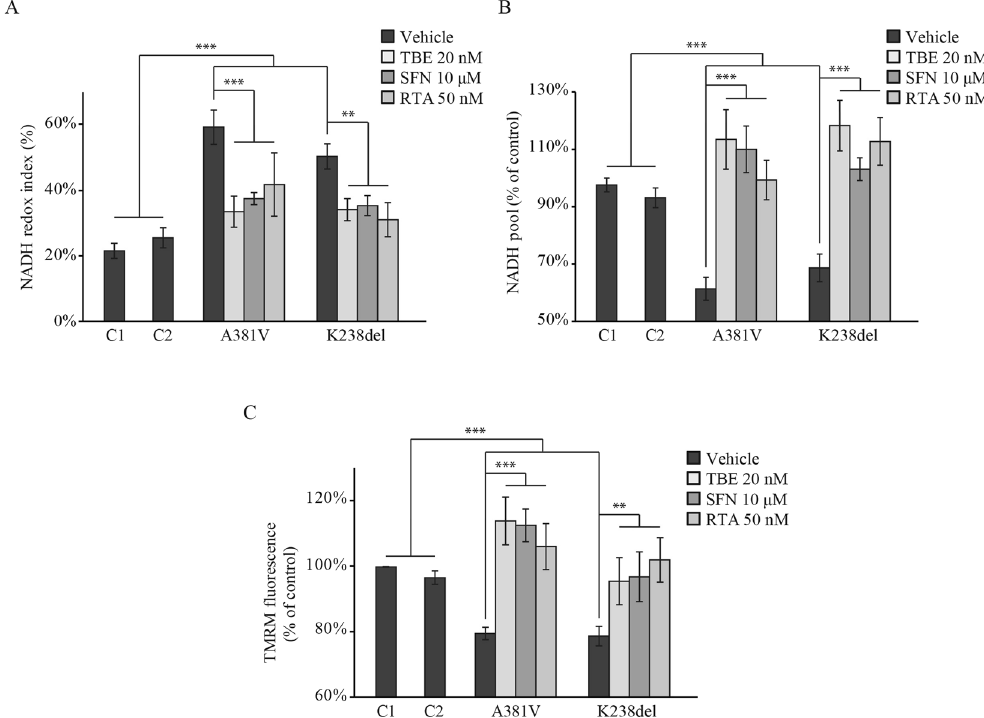
Figure 5. Nrf2 activators restore the p62 deficient phenotype. ( A) NADH redox index was evaluated after incubation with the Nrf2 activators TBE-31(TBE, 20 nM), sulphoraphane (SFN, 10 μ M) and the synthetic triterpenoid RTA-408 (RTA, 50 nM). Cells were plated on 25 mm coverslips in 6 well plates. When they reached 70% confluency, cells were treated 24 hours with TBE, SFN and RTA separately. NADH redox index was calculated as the basal level relative to maximal respiration after FCCP (1 mM) (0%) and inhibited respiration after NaCN (1 mM) (100%) (see Fig. 2B) in fibroblasts from patients carrying the A381V and K238del pathogenic mutations in p62 compared to two control fibroblasts (C1, C2) in presence of the Nrf2 activators. All data represents the mean of at least 3 independent experiments ± SEM. In all cases ** indicates p < 0.01 and *** indicates p < 0.001 compared with the values in control cells. ( B ) NADH pool expressed as absolute values between maximal and minimal respiration (see Fig. 2B) in control and patient fibroblasts in presence of the Nrf2 activators. Experimental conditions were the same as in ( A ). All data represents the mean of at least 3 independent experiments ± SEM. In all cases *** indicates p < 0.001 compared with the values in control cells. ( C ) The ΔΨ m was analyzed in fibroblasts from patients and controls upon activation of Nrf2. Experimental conditions were the same as in ( A ). All data represents the mean of at least 3 independent experiments ± SEM. In all cases ** indicates p < 0.01 and *** indicates p < 0.001 compared with the values in control